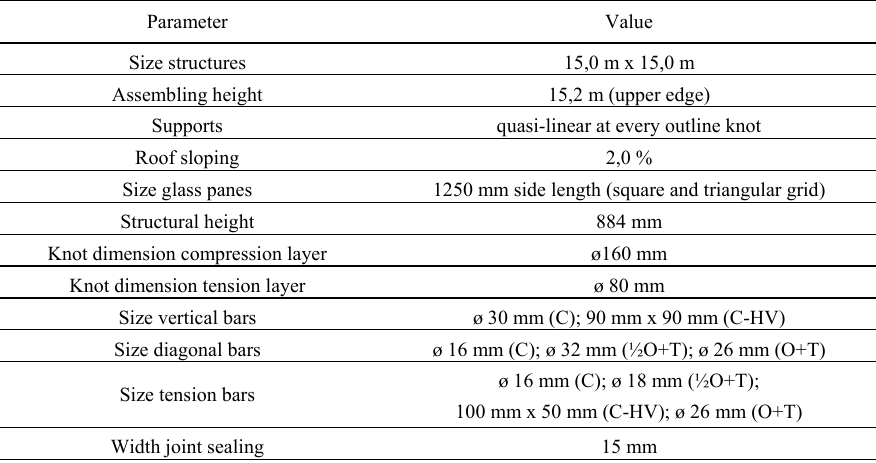
Table 1: Characteristics of the relevant date for the comparable roof structures